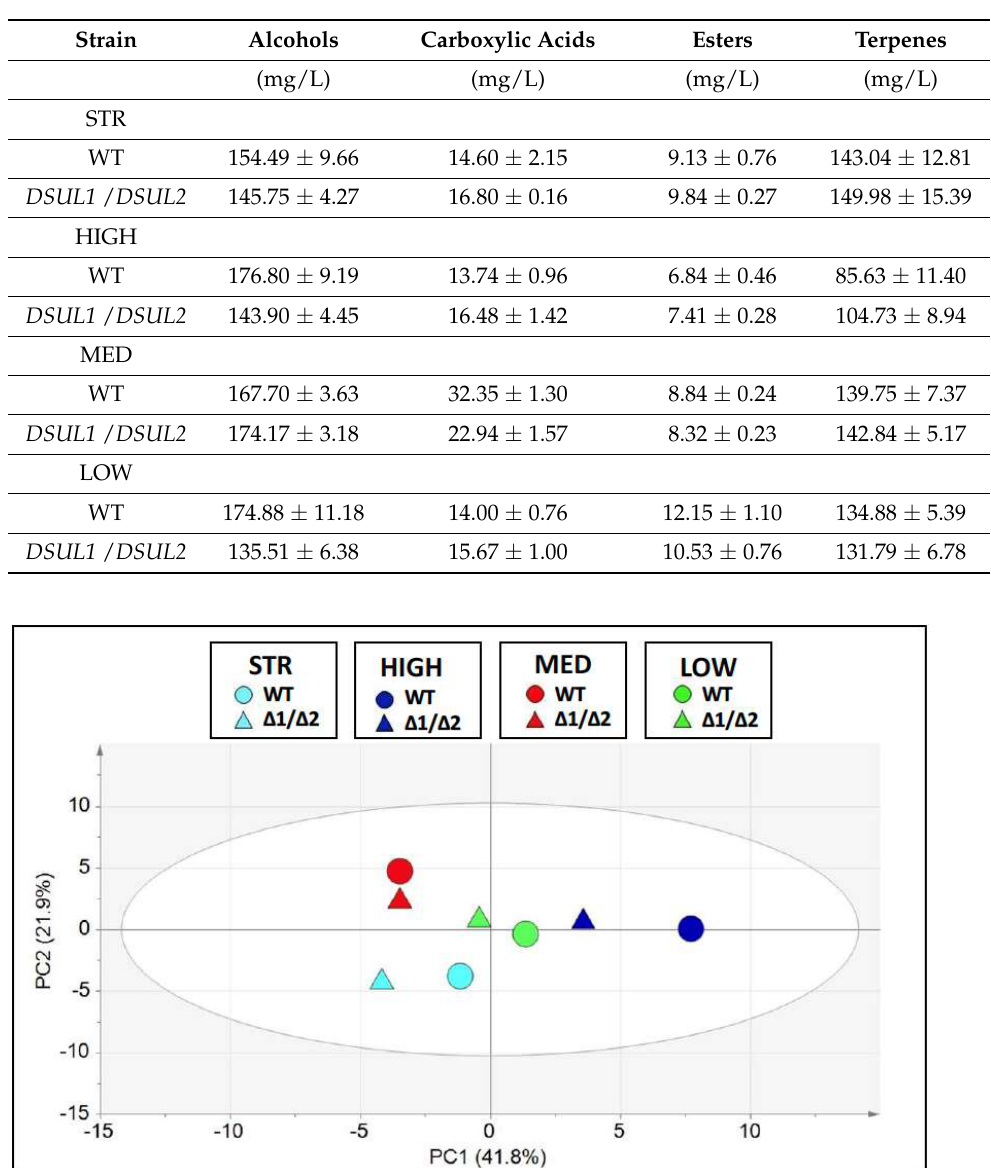
Table 2. Levels of main volatile compounds detected by GC-MS assay (values are expressed as mean ± S.E., n = 4).